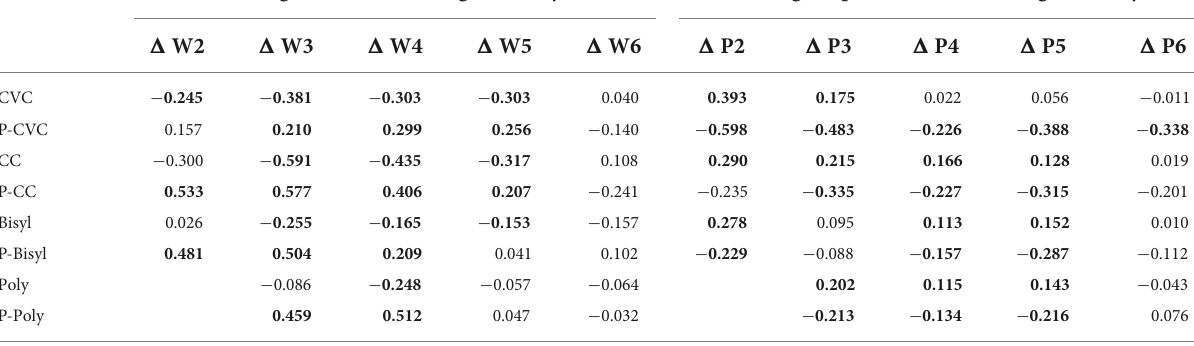
TABLE 6 Change of word and pseudoword decoding efficiency in adjacent grades regressed on the preceding levels of word and pseudoword decoding efficiency (estimated unstandardized regression coefficients). Predictors